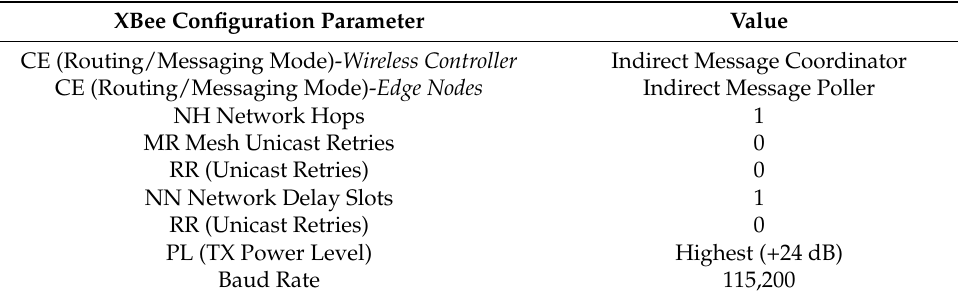
Table 1. Configuration parameters of the XBee